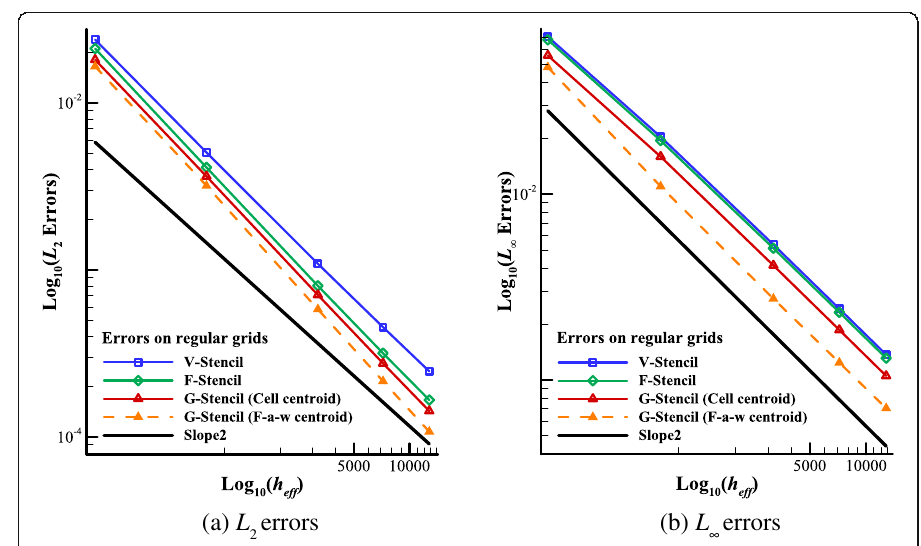
Fig. 20 ( a ) L 2 and ( b ) L ∞ errors. Errors of different stencils on regular grids with AR ≈ 4